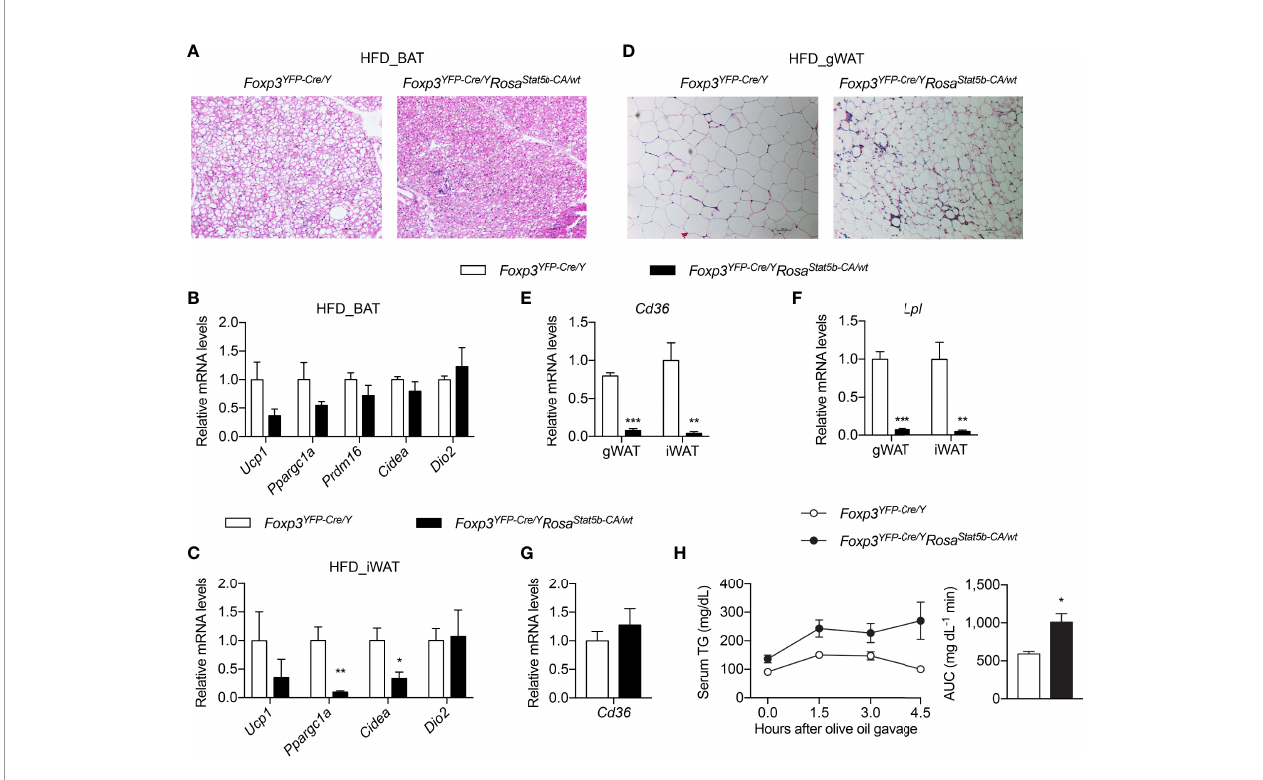
FIGURE 6 | Thermogenesis and lipid metabolism in Foxp3 YFP-Cre/Y Rosa26 Stat5b-CA/wt mice. (A) BAT histology of HFD-fed Foxp3 YFP-Cre/Y and Foxp3 YFP-Cre/ Y Rosa26 Stat5b-CA/wt mice. (B, C) Expression of thermogenic genes in BAT (B) and iWAT (C) of HFD-fed Foxp3 YFP-Cre/Y (n = 7) and Foxp3 YFP-Cre/Y Rosa26 Stat5b-CA/wt (n = 5) mice. (D) Gonadal WAT histology of HFD-fed Foxp3 YFP-Cre/Y and Foxp3 YFP-Cre/Y Rosa26 Stat5b-CA/wt mice. (E) Cd36 and (F) Lpl gene expression in WAT of HFD-fed Foxp3 YFP-Cre/Y (n = 7) and Foxp3 YFP-Cre/Y Rosa26 Stat5b-CA/wt (n = 5) mice. (G) Expression of the Cd36 gene in duodenum of HFD-fed Foxp3 YFP-Cre/Y (n = 7) and Foxp3 YFP-Cre/Y Rosa26 Stat5b-CA/wt (n = 5) mice. (H) Oral lipid tolerance test of HFD-fed Foxp3 YFP-Cre/Y (n = 9) and Foxp3 YFP-Cre/Y Rosa26 Stat5b-CA/wt (n = 6) mice. Serum triglyceride levels were determined. Area under curve (AUC) is shown to the right. Data are presented as mean ± SEM. *, p < 0.05; **, p < 0.01; ***, p < 0.001 by unpaired student ’ s